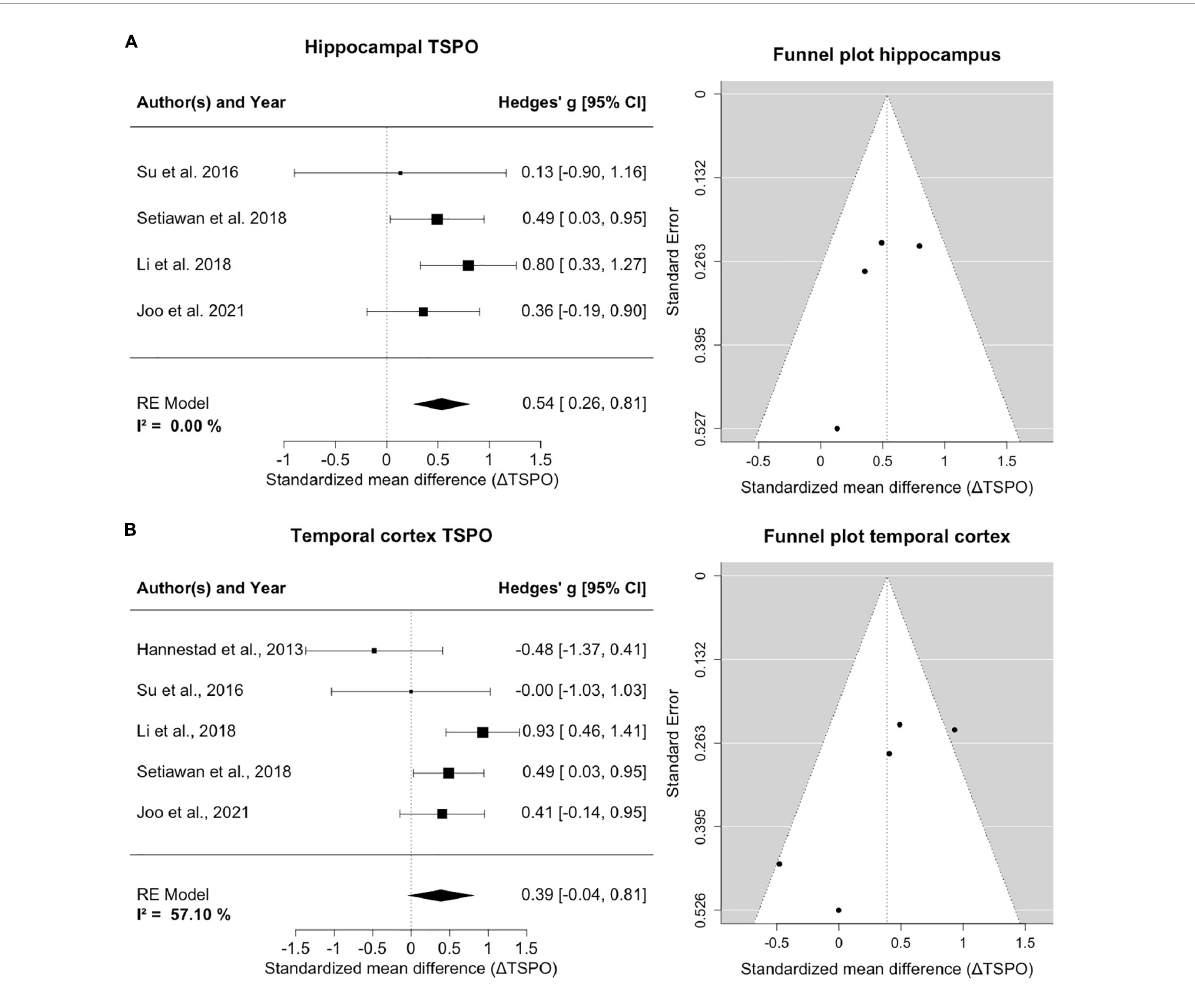
FIGURE3 TSPO binding is increased in hippocampus and temporal cortex of MDD patients compared to controls. (A) The forest plot for TSPO binding in the hippocampus shows an effect size of 0.54, 95%CI: (0.26, 0.81). The funnel plot of hippocampal estimates is shown on the right side. (B) The forest plot of TSPO binding in the temporal cortex indicates an effect size of 0.39, 95%CI: (–0.04, 0.95). The corresponding funnel plot is displayed